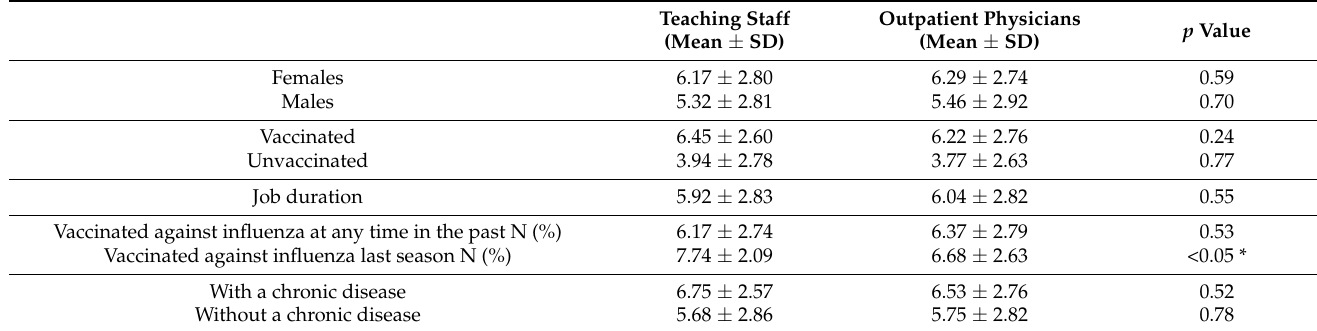
Table 6. Level of fear of COVID-19 among respondents.